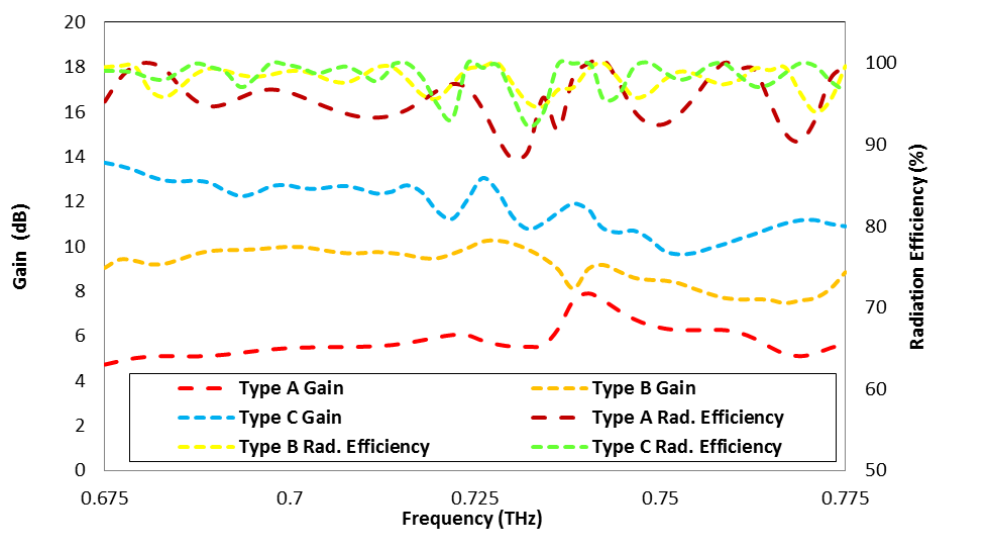
Figure 15. Comparison of gains and radiation efficiencies of Type A, Type B, and Type C antenna arrays.